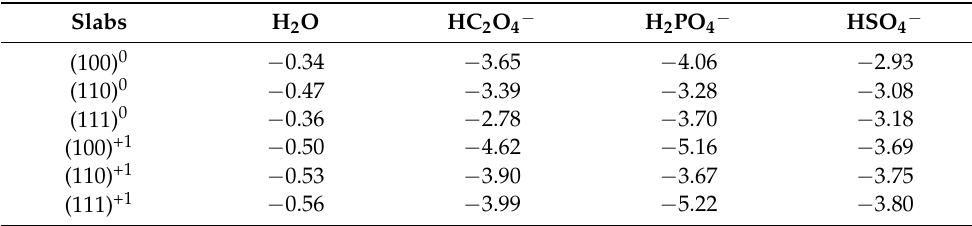
Table 1. The adsorption energies (E ads /eV) of small